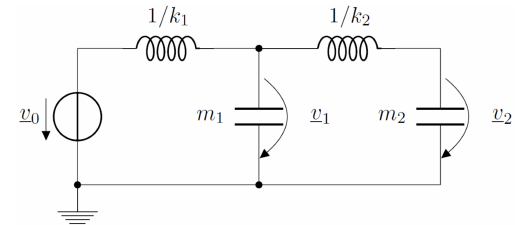
Figure 4. Simplified circuit model from Fig. 3 without damping and external interaction, i.e. d i = 0 ,k 3 = 0.